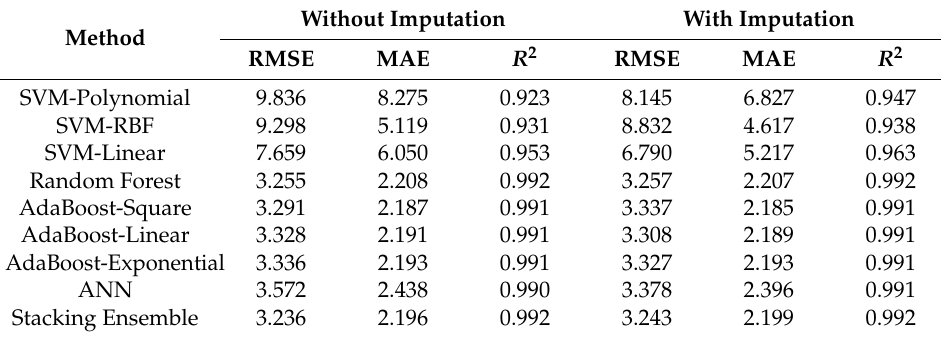
Table 4. Results of ML Algorithms for Zhongli F1-AQI